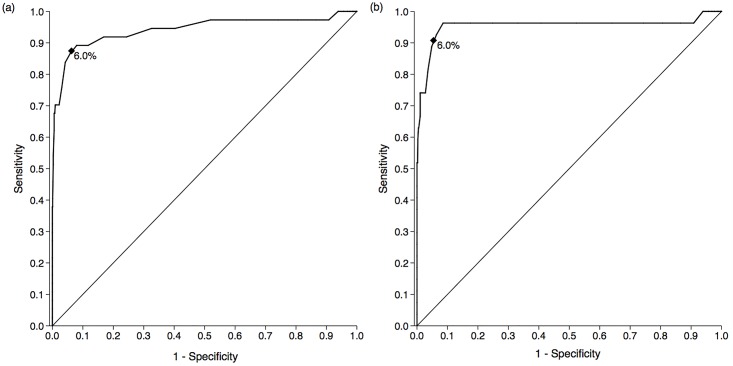
Receiver Operating Curve (ROC) curves for HbA1c for the detection of diabetes with OGTT (a) and FPG (b) as the reference.Area under the ROC curve: 0.94 (95% CI 0.88–0.99) with oral glucose tolerance test (OGTT) as the reference (a) and 0.95 (95% CI 0.88–1.00) with fasting plasma glucose (FPG) as the reference (b). Optimal HbA1c cut off: 42 mmol/mol (6.0%) with OGTT as the reference (sensitivity 89.2%, specificity 92.0%) (a), and 42 mmol/mol (6.0%) with FPG as the reference (sensitivity 96.3%, specificity 91.4%) (b).